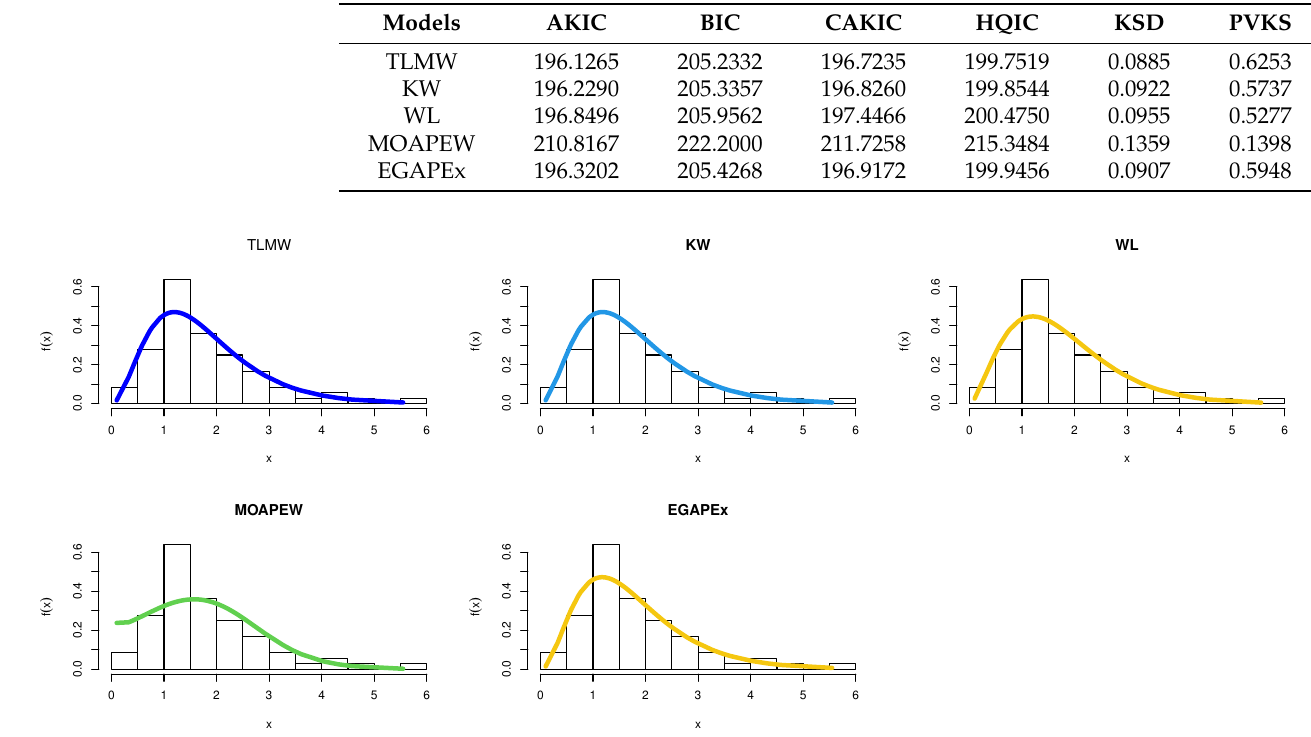
Figure 11. Pdf for different models for Guinea Pigs data.